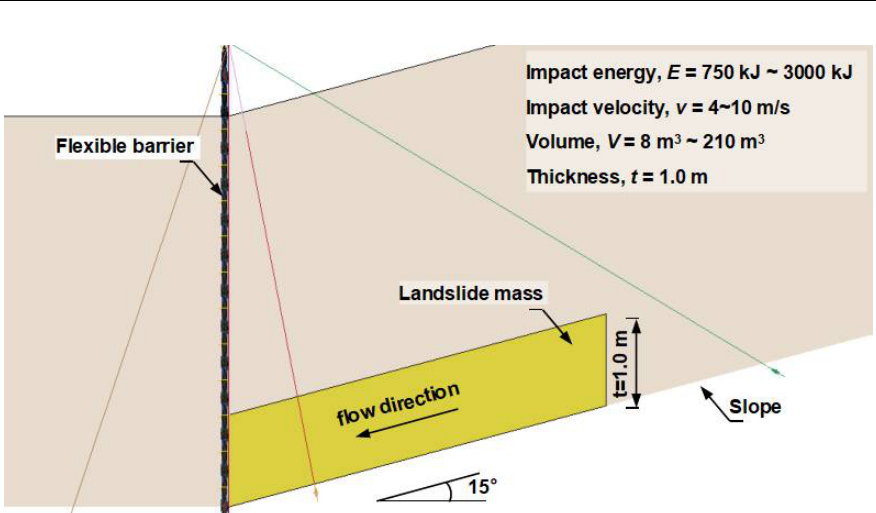
Figure 12. Side view of the simulation model for the parametric study. Table 4. Simulation schedule for a parametric study.